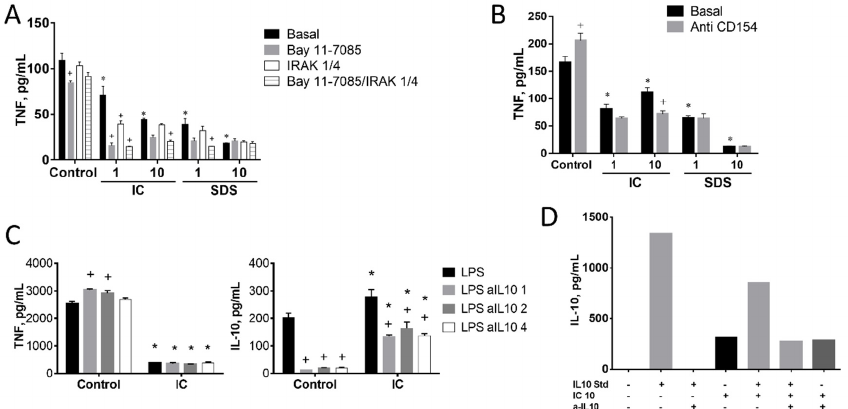
Figure 6. Involvement of IL-10 on the inhibition of TNF production by immunoglobulin concentrate (IC) and spray dried serum (SDS) in rat splenocytes. ( A ) Effect of NF- κ B and IRAK1/4 inhibitors on TNF production. Bay 11-7082 (10 µM) and the IRAK 1/4 inhibitor 1 (10 µM) were added to the cell culture medium together with SDS and IC for 48 h. ( B ) Effect of a blocking anti-CD154 antibody on TNF production, following the same protocol. ( C ) Effect of a blocking anti-IL-10 antibody (1, 2 or 4 µg/mL) on TNF and IL-10 secretion, following the same protocol. ( D ) Evaluation of IC immunoreactivity by rat IL-10 ELISA and blockade by rat anti-IL-10 antibody. IC (10 mg/mL) was measured with a rat ELISA as described in Materials and Methods and the signal compared with that of the rat IL-10 ELISA standard (1250 pg/mL). The effect of incubation for 4 h at 37 ◦ C with a blocking anti-IL10 antibody (1 µ g/mL) was also assessed. RPMI medium without FBS was used in all cases. Cytokines were measured in the culture medium by ELISA. + p < 0.05 vs. the corresponding Basal group; * p < 0.05 vs. Control